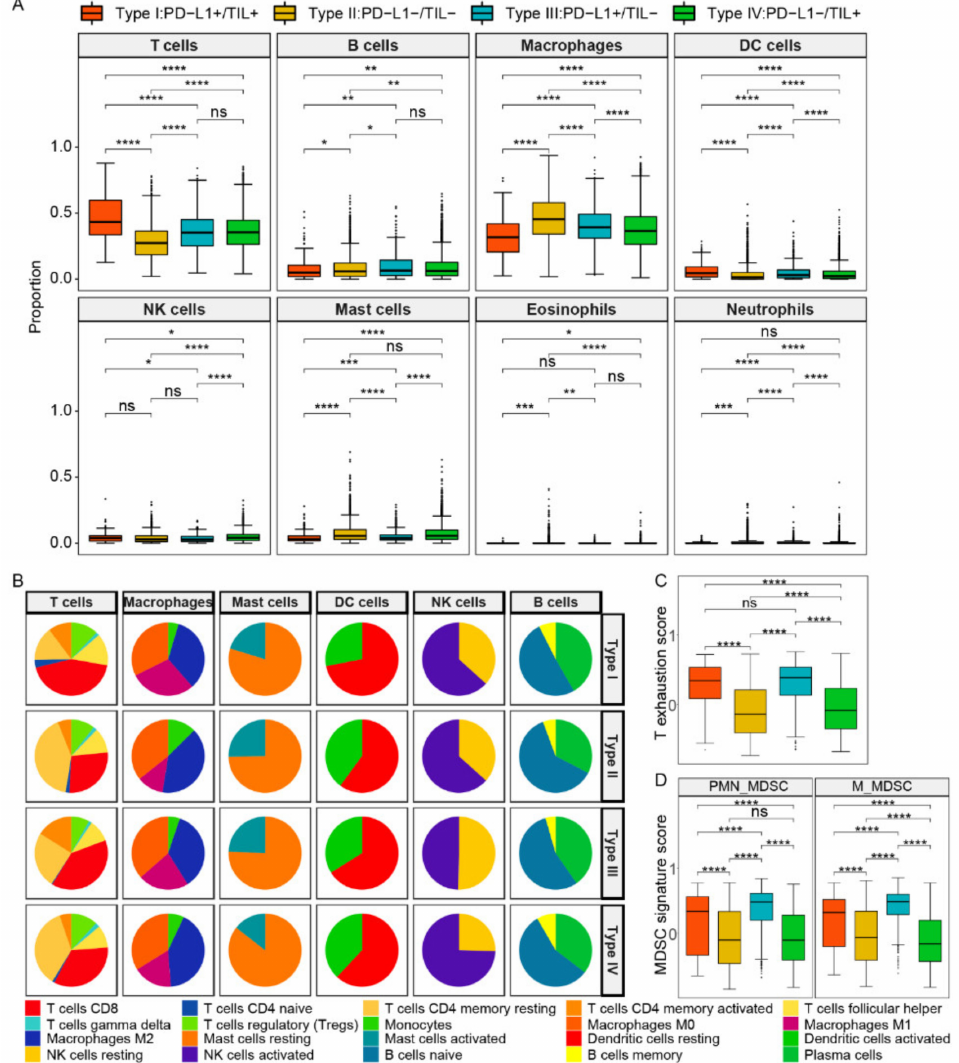
Figure 2. The composition and abundance of immune cells among four TIME subtypes. ( A ) The abundance difference among eight types of immune cells within four subtypes. ( B ) The abundance difference of six main subclass immune cells in each subtype. ( C ) The T cell exhaustion score between four subtypes. ( D ) The MDSC signature score between four subtypes. Abbreviations: M_MDSCs: monocytic MDSCs, PMN_MDSCs: polymorphonuclear MDSCs. ****, p < 0.0001; ***, p < 0.001; **, p < 0.01; *, p <